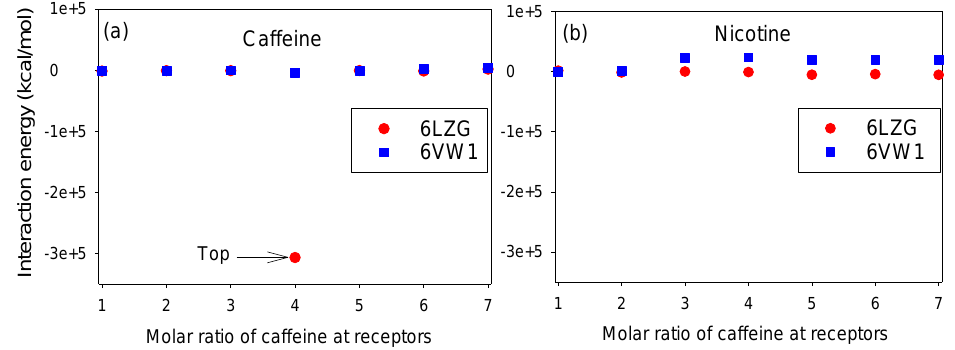
Figure 5. The interaction energies (IEs) for different ratios of ( a ) caffeine and ( b ) nicotine structures with 6LZG and 6VW1.